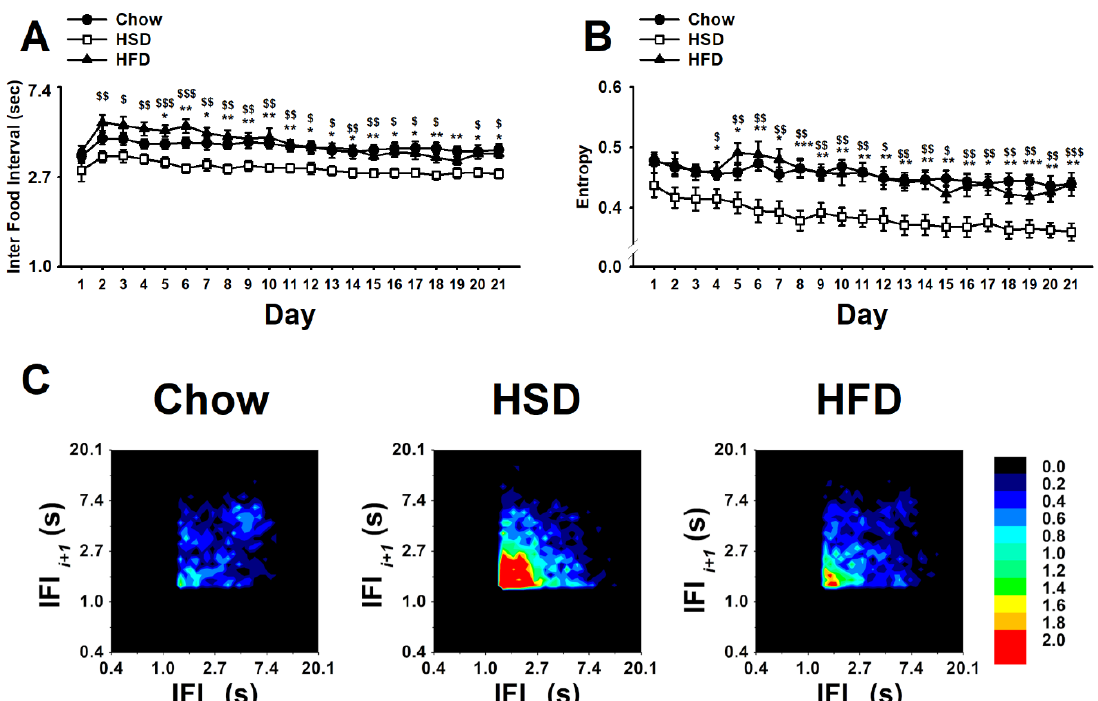
Figure 3. Effects of daily 1-h operant self-administration of Chow, HSD, or HFD on ( A ) inter food interval (sec), ( B ) entropy, and ( C ) return map in female Sprague Dawley rats ( n = 10 / group). Rats were given the chance to self-administer one of the three diets in a fixed ratio 1 schedule during a 21-day period. Chow was otherwise freely available in the home cages. Panels represent M ± SEM.